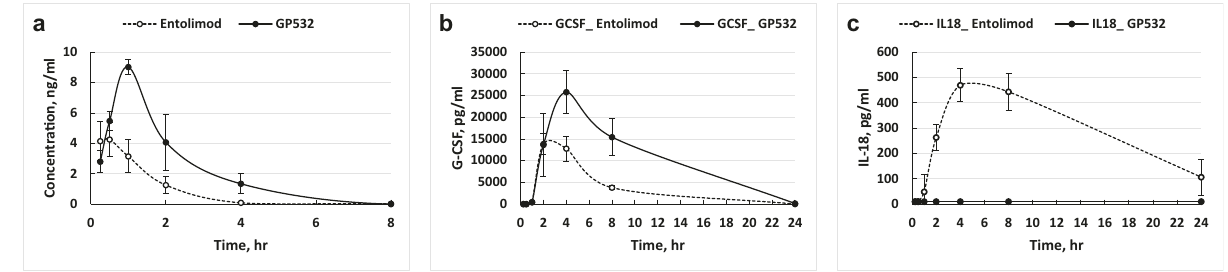
Fig. 6 Pharmacological characteristics of GP532 and entolimod. a PK analysis of serum drug concentrations by ELISA after s.c. injection of entolimod and GP532 (1 μ g/injection) in C57BL/6 mice ( n = 5 mice per group per time point). b , c Serum concentrations of entolimod PD biomarker G-CSF ( b ) and in fl ammasome biomarker IL-18 ( c ) in the same groups of mice as in ( a ). Mean values ± SD are shown for fi ve mice per group per